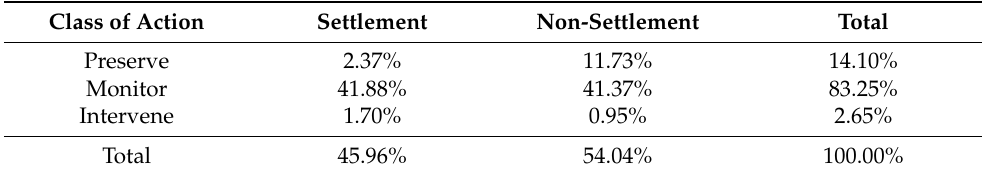
Table 18. Distribution of settlement category per IUHI class of action.